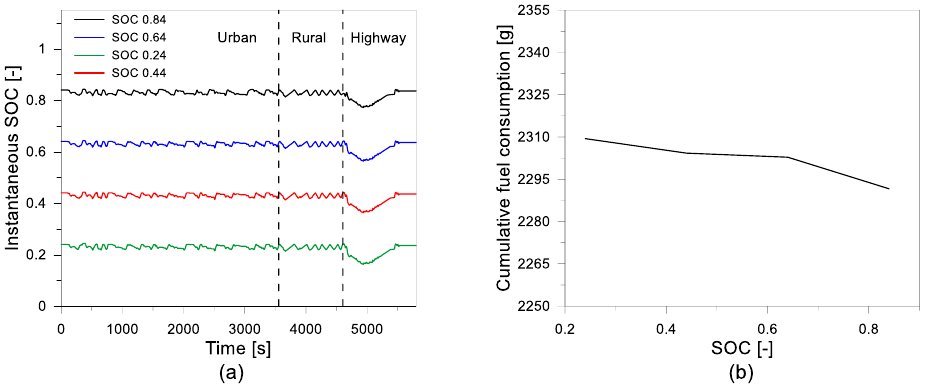
Figure 9. Instantaneous SOC ( a ) and final fuel consumption ( b ) for different initial SOC at the RDE driving cycle.